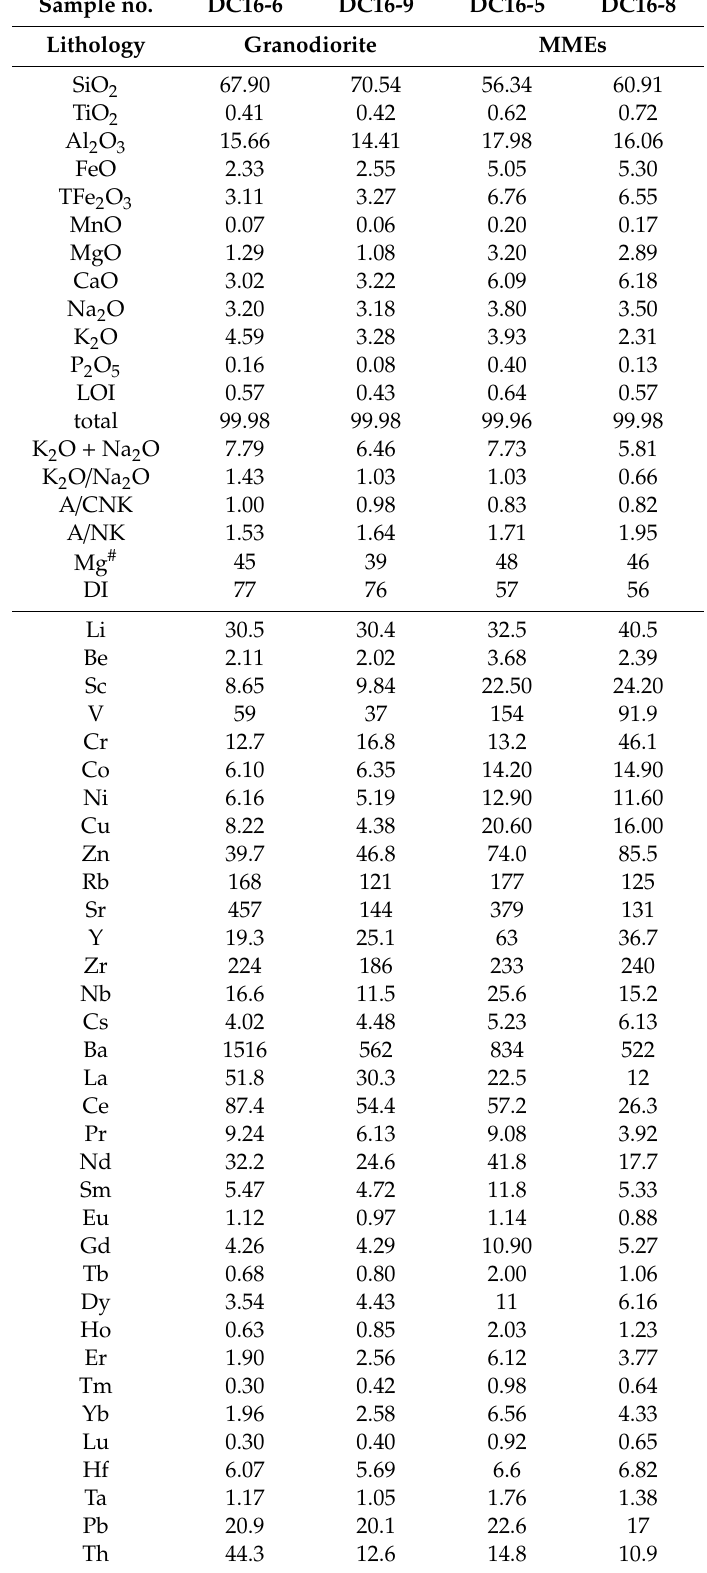
Table 1. Whole-rock major (wt. %), trace elements (ppm) data for granodiorite and MMEs of the Daocheng batholith in the Yidun